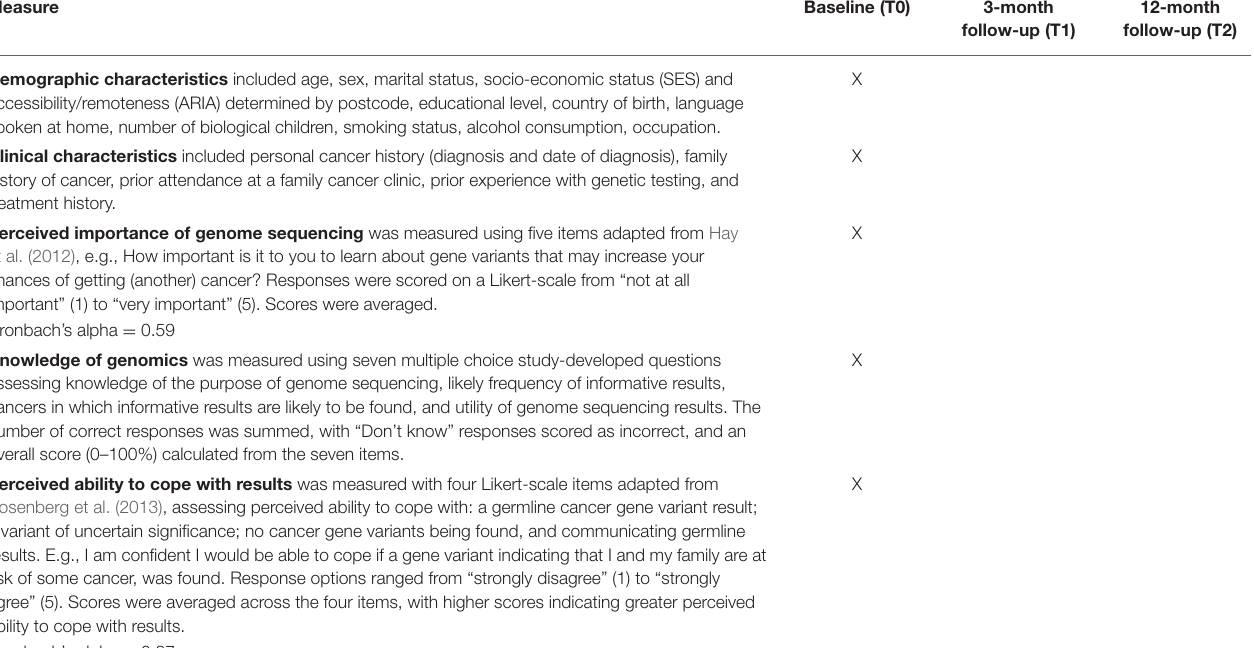
12-month follow-up (T1) follow-up